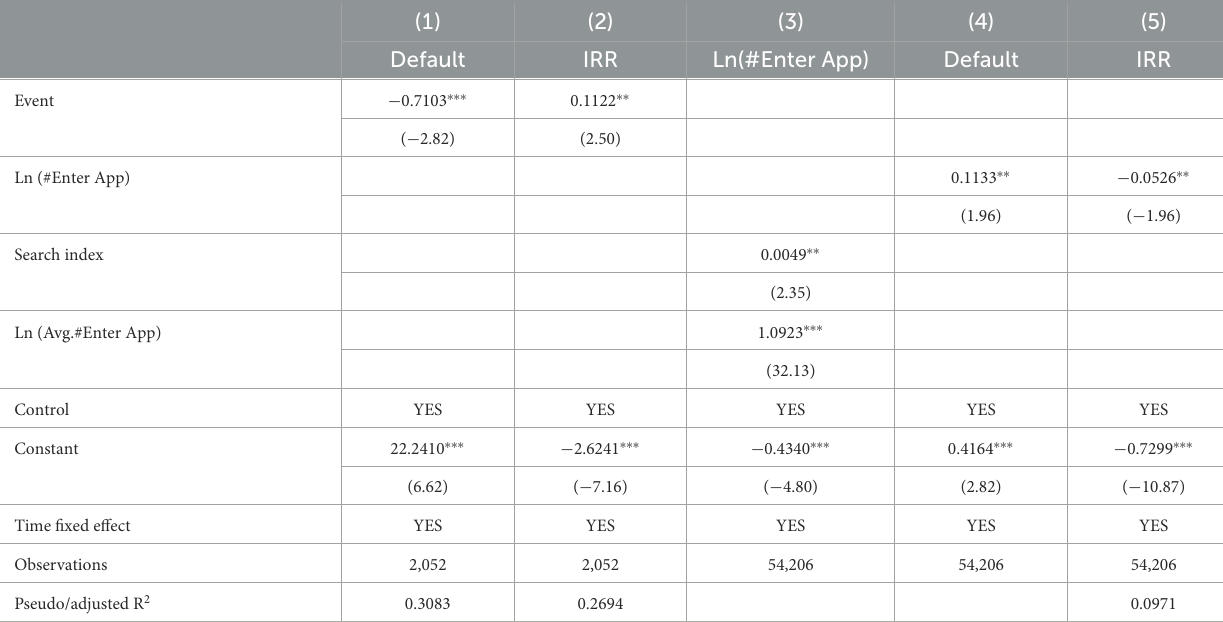
TABLE 3 Addressing the endogeneity